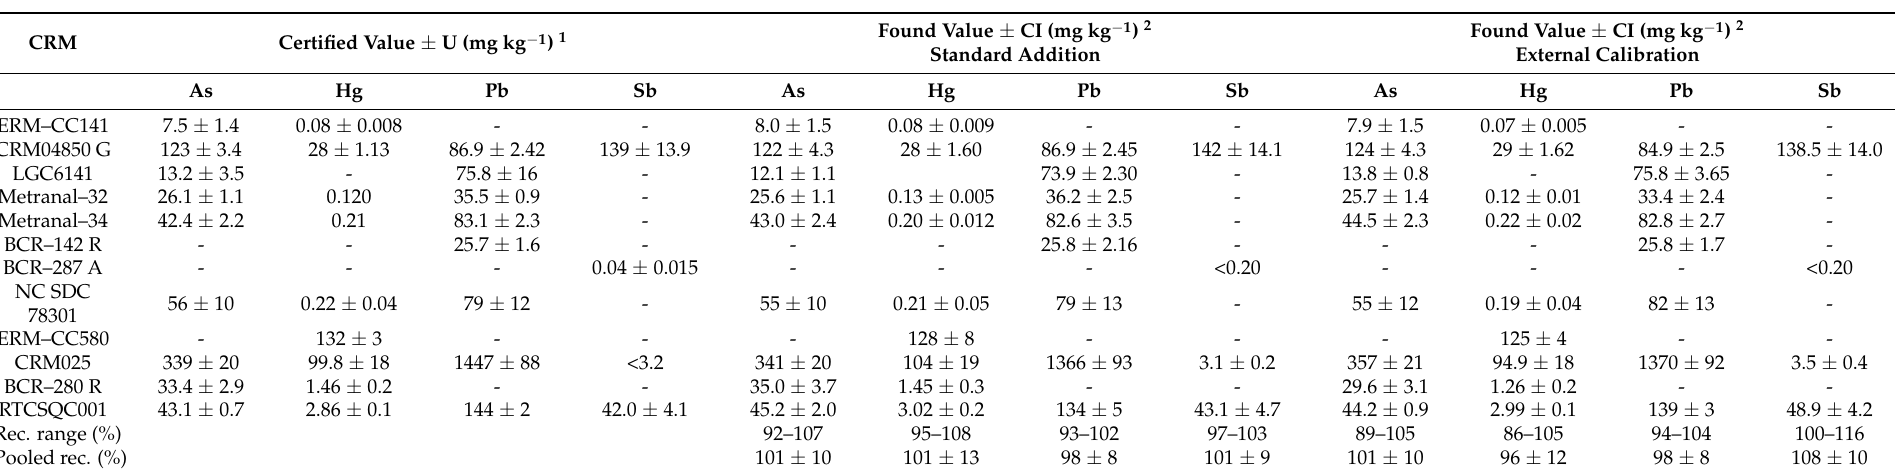
Table 4. Results for the analysis of soil and water sediment CRMs by the SSETV- µ CCP-OES method using Maya2000 Pro microspectrometer for As, Hg, Pb, and Sb using standard addition and external calibration.